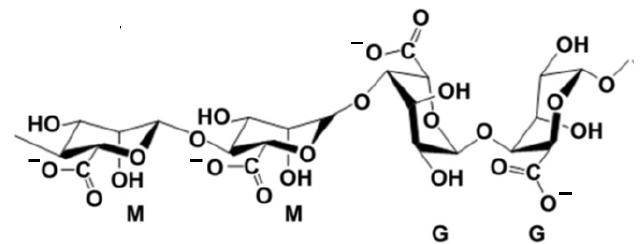
Figure 1. Chemical structure of alginate.